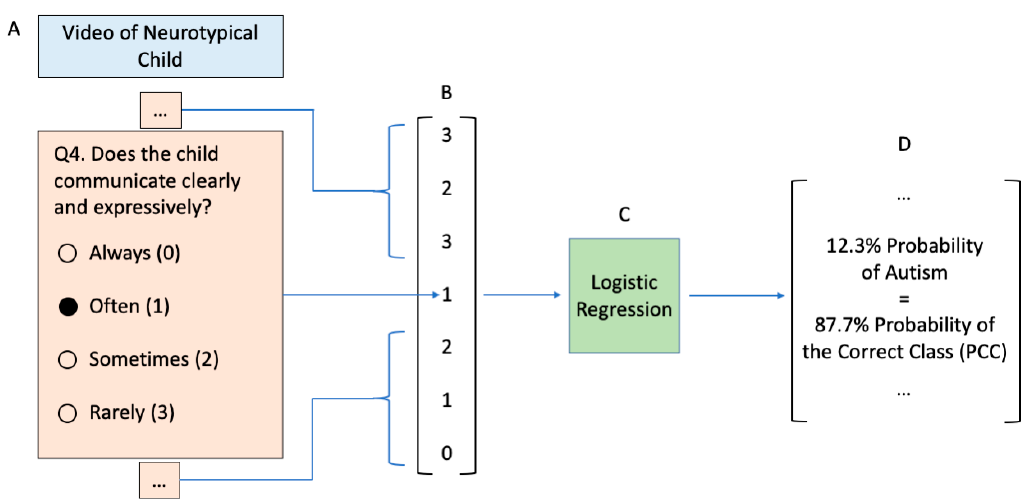
Figure 1. The process for calculating a probability score of autism from the categorical answers provided by crowdsourced workers. ( A ) Workers answer a series of multiple-choice questions per video that correspond to ( B ) categorical ordinal variables used in the input feature matrix to the ( C ) logistic regression classifier trained on electronic medical record data. This classifier emits a probability score for autism, which is the probability of the correct class when the true class is autism and 1 minus this probability when the true class is neurotypical (the latter case is depicted). ( D ) A vector of these probabilities is used to calculate mean worker and mean video probabilities of the correct class.